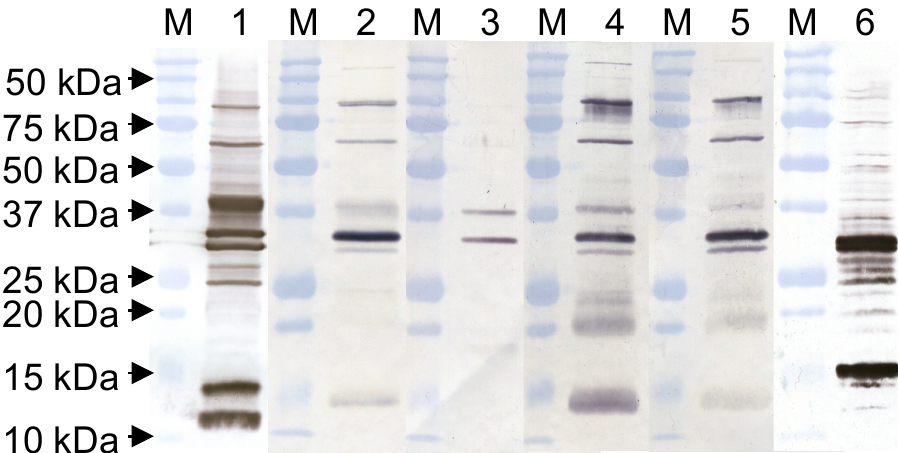
Figure 2. Western blot on 5 µg VACV Elstree gradient. Anti-MVA-polyclonal rabbit Ab (1) served as a positive control for VACV. Lanes 2 to 5 represent the proteins detectable by the volunteer sera (2 = Volunteer 1, 3 = Volunteer 2, 4 = Volunteer 3, 5 = Volunteer 4). With the polyclonal hyperphage preparation (6), a broad range of VACV proteins was verified. The used conjugates were anti-rabbit IgG (whole molecule) peroxidase conjugate developed in goat, anti-human IgG (Fc specific) peroxidase conjugate developed in goat, and anti-M13-HRP, respectively. M marks the protein ladder for each